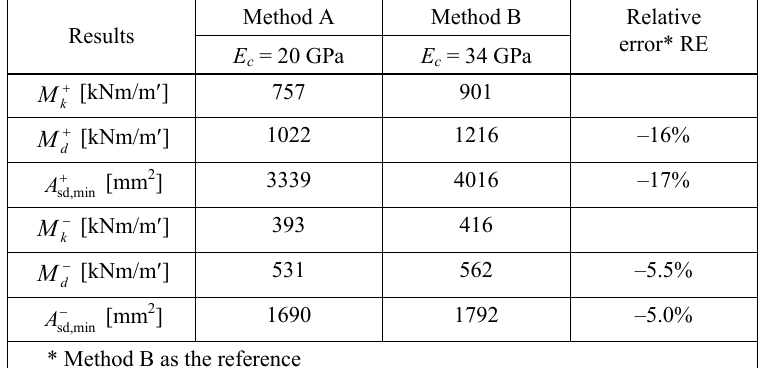
Table 2. Minimal cross section area for reinforcement computed for the maximal design bending moment M d